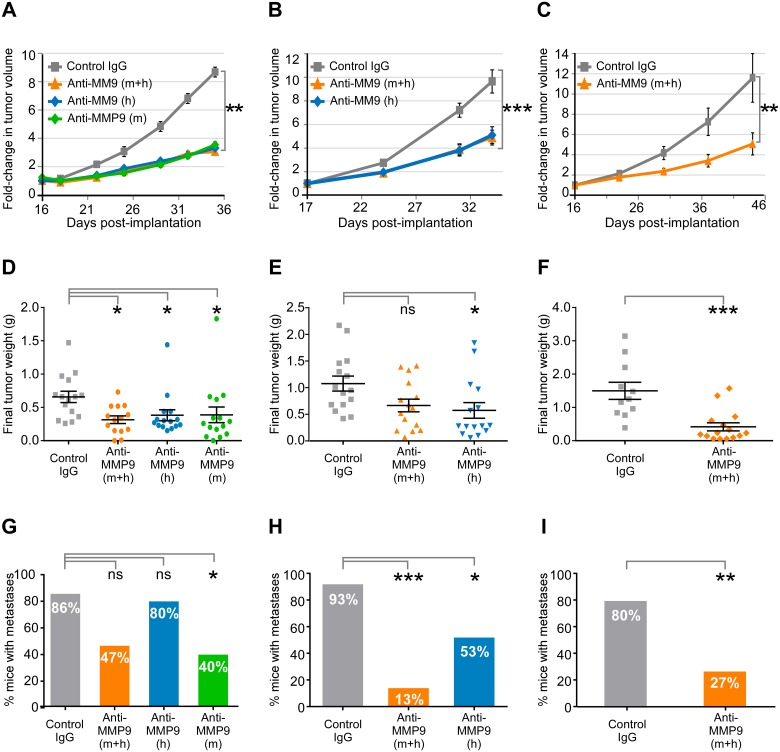
Efficacy of MMP9 inhibition in an orthotopic xenograft model of CRC.Tumors in the HCT116 model were allowed to reach a volume of 70–100 mm3 before treatment with a control IgG or with antibodies targeting mouse MMP9 (AB0046; anti-MMP9 [m]), human MMP9 (AB0041; anti-MMP9 [h]), or both (anti-MMP9 [m+h]). Each antibody was dosed twice a week at 15 mg/kg, whether singly or in combination, and study groups containing AB0046 received a loading dose of 50 mg/kg on the day prior to initiation of treatment. Three separate studies are shown; Study 3 (panels A, D, G); Study 2 (panels B, E, H), and Study 1 (panels C, F, I). (A-C) Change in tumor growth: (A) Study 3, (B) Study 2, (C) Study 1. For a given mouse, raw tumor volume measurements (by caliper) were normalized to the corresponding initial tumor volume (prior to the start of treatment initiation). Normalized volumes for individual mice were then averaged for each timepoint;plots show group mean +/- SEM; standard error of the mean. Significance was assessed by Kruskal-Wallis analysis (A, B) or by Mann-Whitney analysis (C). Treatment was initiated 16 days after surgical implantation of tumor fragments for Studies 1 and 3, and 17 days after implantation for Study 2. The last measurement of tumor volume was 35 days post-implantation for Study 3, 34 days post-implantation for Study 2, and 44 days post-implantation for Study 1. (D-F) Final tumor weight: (D) Study 3, (E) Study 2, (F) Study 1. Plots show mean tumor weight +/- SEM. Significance was assessed by Kruskal-Wallis analysis (D,E) or by Mann-Whitney analysis (F). Mice were terminated at 20 days (Study 3), 18 days (Study 2), or 32 days (Study 1) after treatment initiation, which corresponds to 36 days (Study 3), 35 days (Study 2), or 48 days (Study 1) after tumor implantation. (G-I) Studies 1–3; metastases incidence at study termination: (G) Study 3, (H) Study 2, (I) Study 1. Metastases were scored as present or absent, based on open-imaging visualization of the GFP-labeled HCT116 tumor cells at areas distal to the primary tumor mass. Plots show the percentage of mice displaying metastases per group. Significance was assessed by Fisher’s exact test. For all panels in Fig 7, P value designations are as follows: * < 0.05, ** < 0.01, *** <0.001, **** < 0.0001.